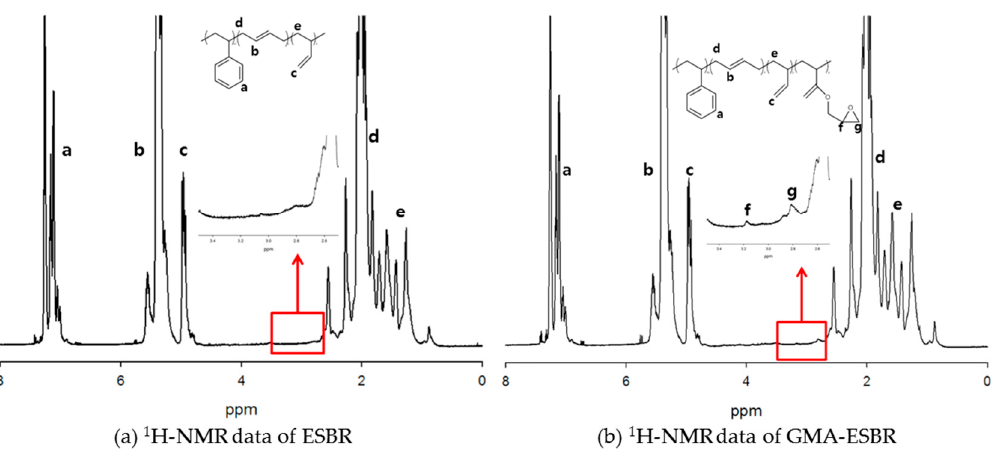
Table 4. Characteristics of ESBR and GMA-ESBR.